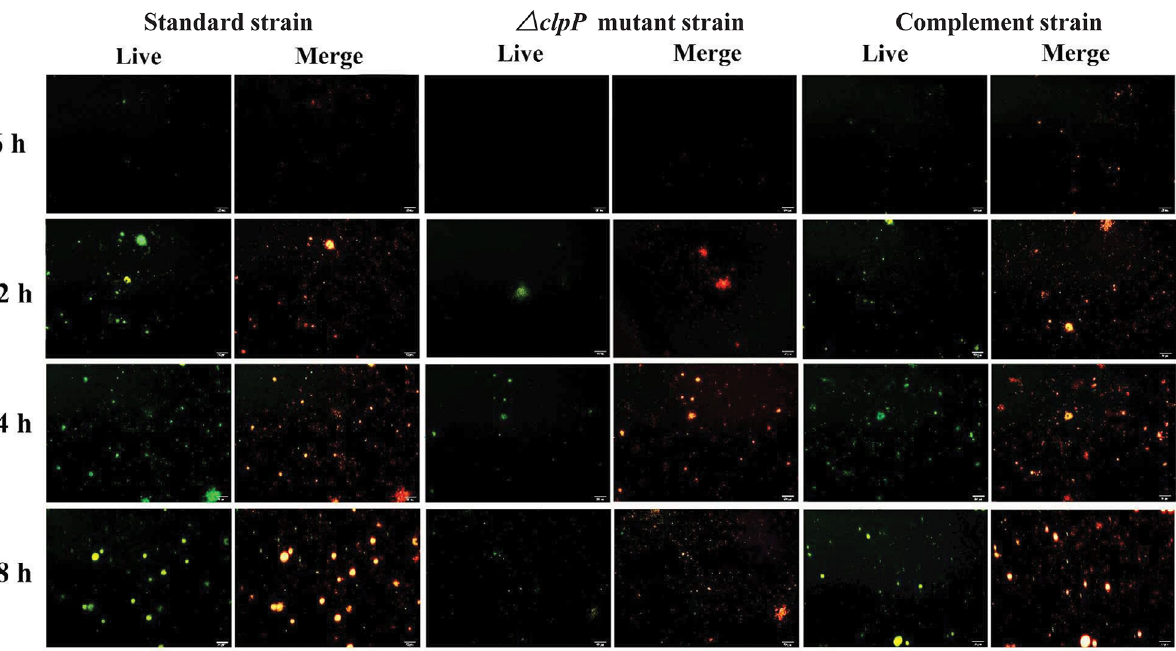
Figure 4- ClpP deletion reduced the polysaccharide matrix mass. Compared to the standard and complemented strains, the mass of polysaccharide matrix in the ∆clpP mutant strains were decreased at 6, 12, 24, and 48 h (Live: staining by FITC-ConA; Merge: staining by FITC-ConA and PI. scale bar = 20 μm)